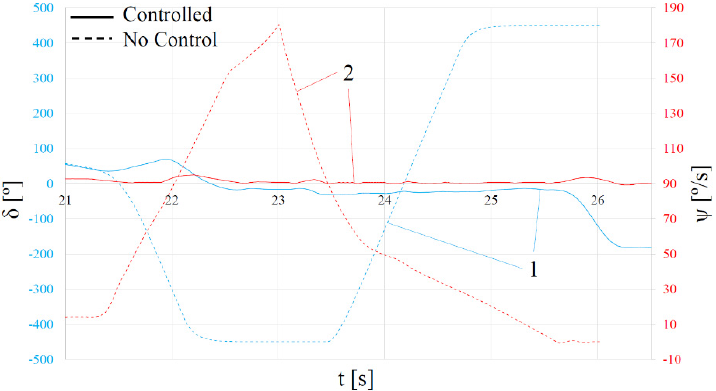
Figure 11. Braking on a curved split ‐μ road with a half dry–half icy surface profile angle curves: 1—steering wheel angle δ , 2—yaw rate ψ .